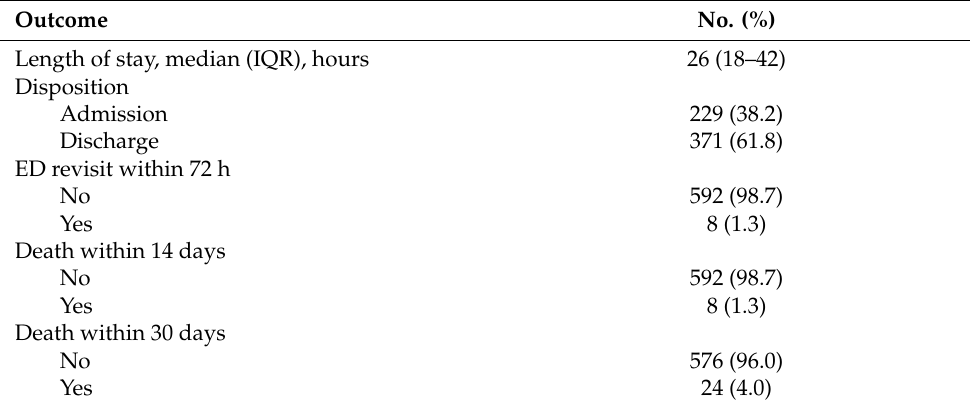
Table 6. Disposition and outcomes of cancer patients with pain placed in an emergency department observation